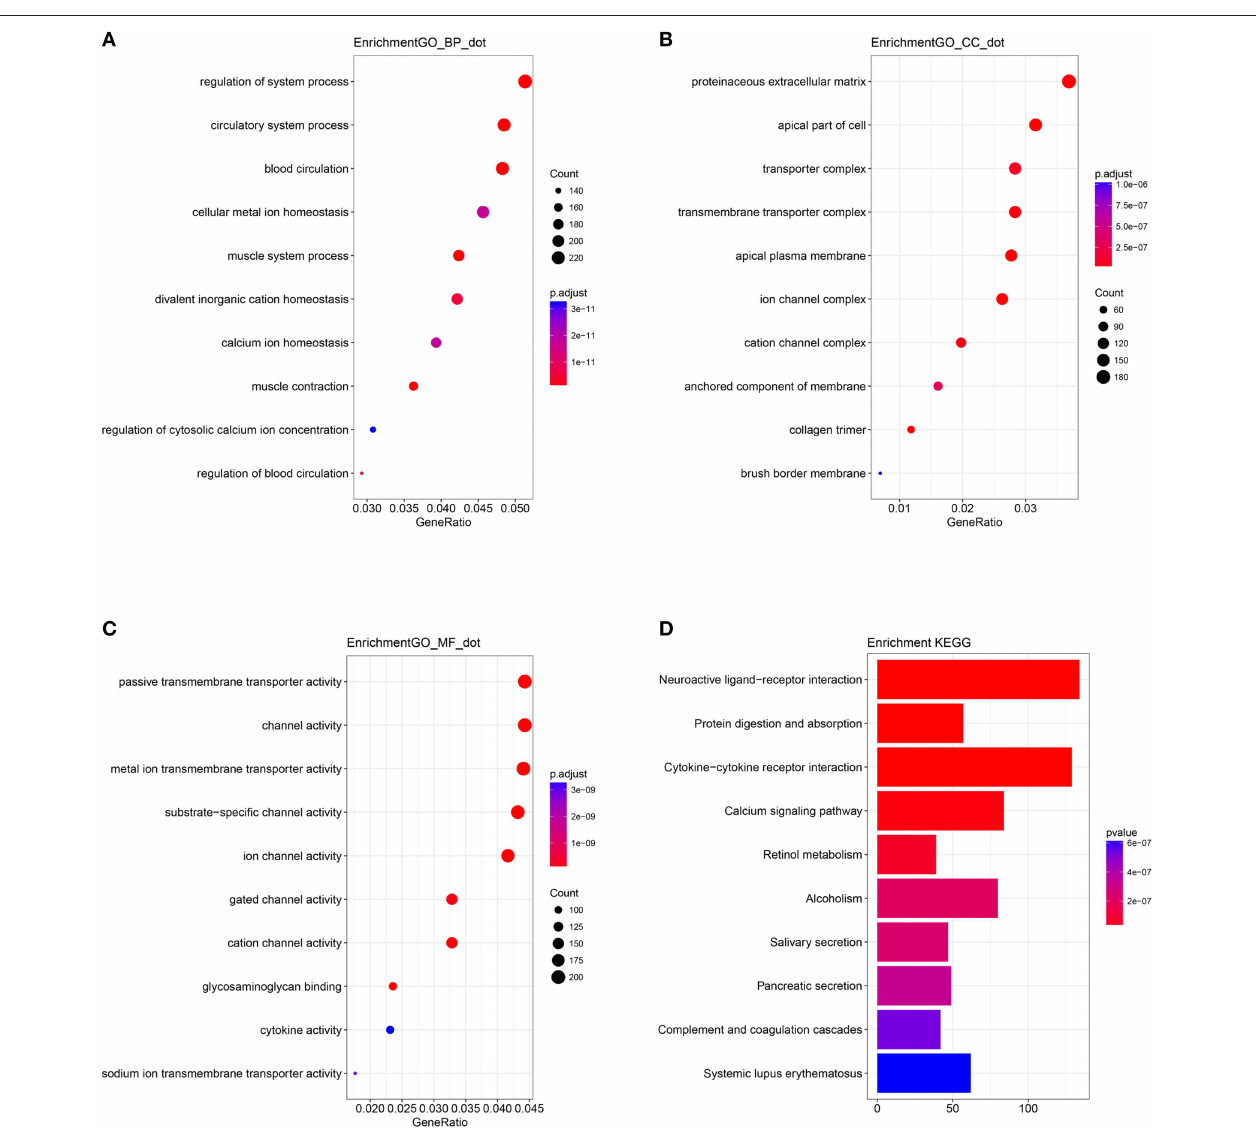
FIGURE 4 | Gene Ontology (GO) terms of genes included in the competing endogenous RNA (ceRNA) network: (A) biological process, (B) cellular component, and (C) molecular function. (D) Kyoto Encyclopedia of Genes and Genomes (KEGG) pathways of genes included in the ceRNA network.